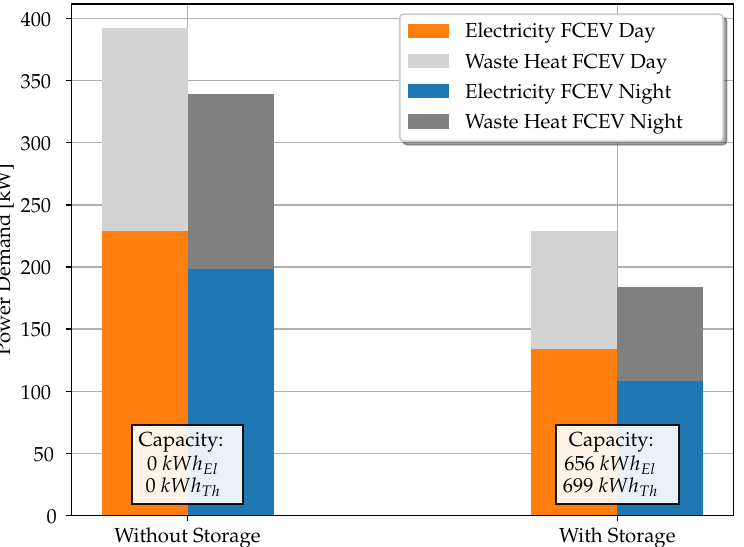
Figure 4. Power demand in the neighbourhood, with and without storage capacities. The blue bars show the required electrical power in the period from 7:00 to 19:00. The orange bars show the necessary electrical power in the period from 19:00 to 7:00. The grey bars above show the waste heat from the FCEVs utilised in addition to the electrical power